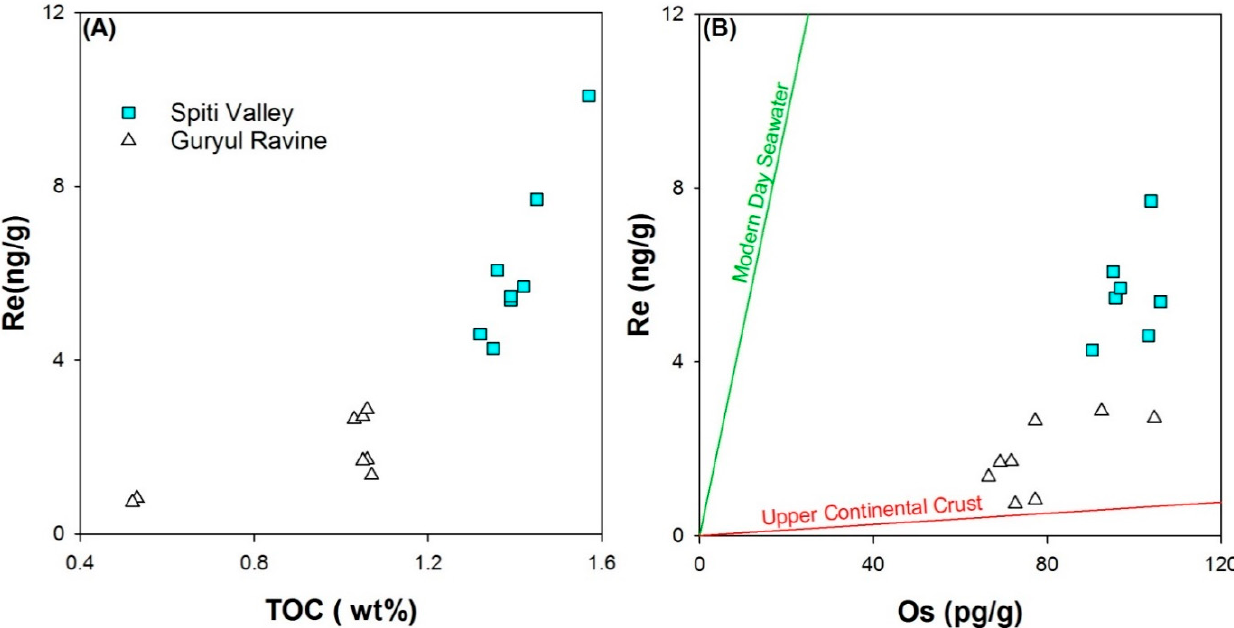
Figure 2. Covariation of Re with ( A ) total organic carbon (TOC) and ( B ) Os for the black shales from the Spiti valley and Guryul Ravine from the Himalaya. Shales from the Spiti valley are characterized with systematically higher TOC, Re and Os concentrations compared to those for the Guryul Ravine samples. For reference, the Re/Os ratio of seawater [51] and upper continental crust (UCC) [49] are also shown in the figure ( B ).